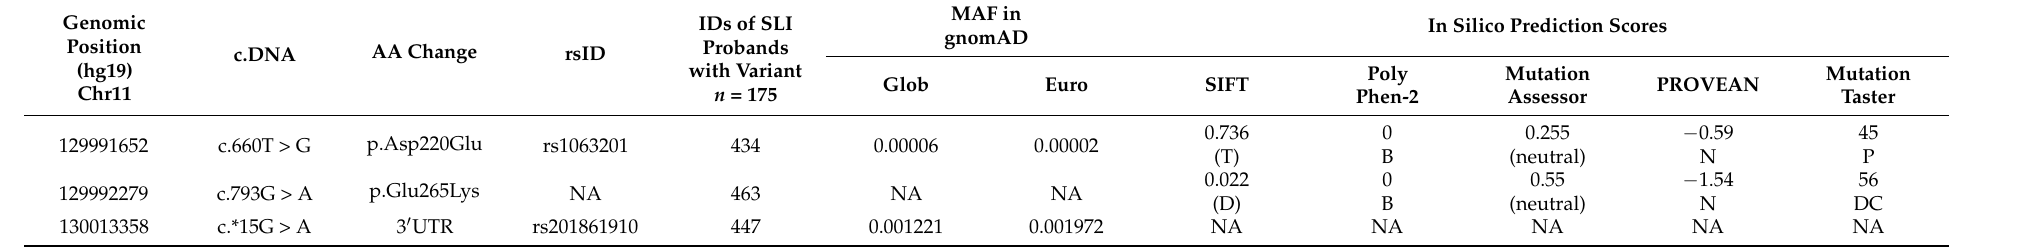
Table 3. Summary of rare variants in APLP2 (NM_001642) identified through Sanger sequencing in probands with SLI.